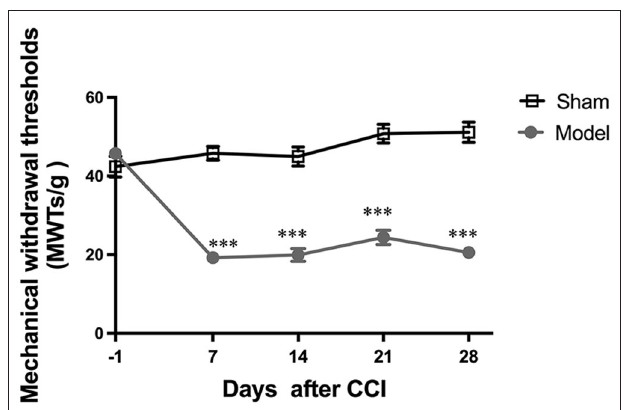
FIGURE 2 | Evaluation of mechanical withdrawal thresholds (MWT). All data are expressed as the Mean ± SEM ( n = 8 per group). *** p < 0.001 vs. the sham